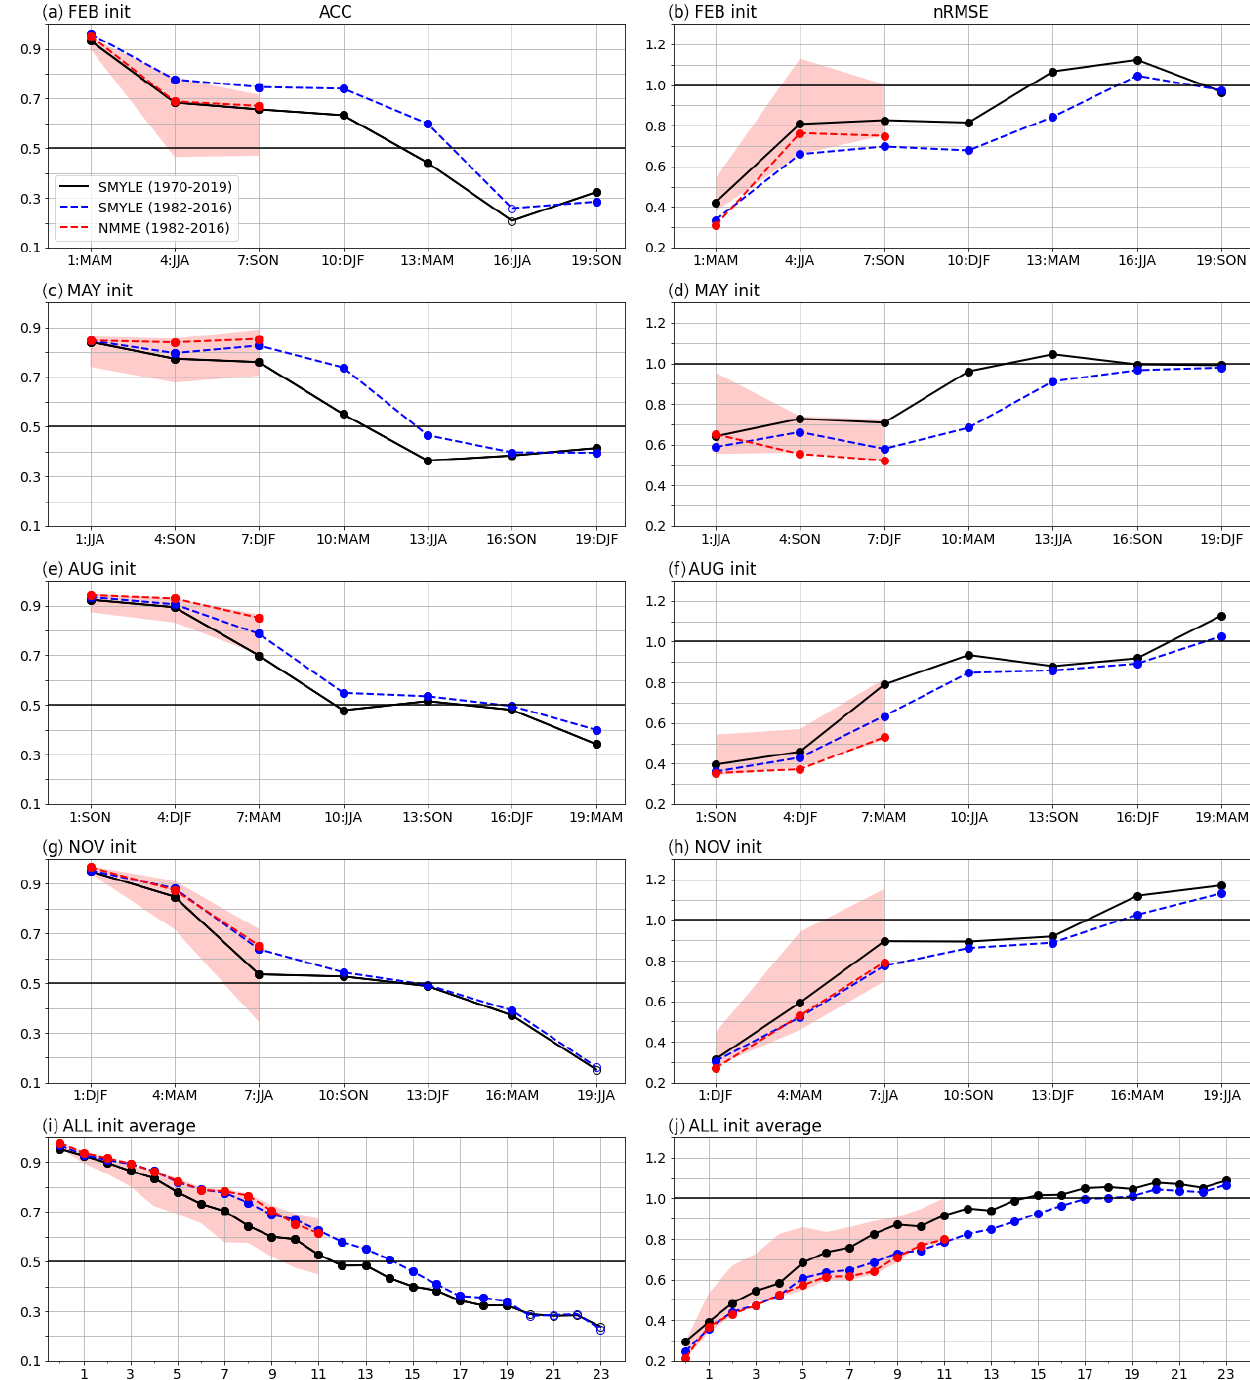
Figure 3. Anomaly correlation coefficient (ACC) on the left and normalized RMSE skill scores on the right for Niño-3.4 SST (regional average over 5 ◦ S–5 ◦ N, 170–120 ◦ W). Panels (a) – (h) show skill for seasonal mean Niño 3.4 for 4 different start months (FEB, MAY, AUG, NOV), with the x axis showing lead time in months and target season. Panels (i) and (j) show skill for monthly mean Niño 3.4 averaged across all 4 start months as a function of lead time in months. Filled symbols for ACC (left panels) indicate significant correlation scores ( p < 0.1). SMYLE skill is shown for two different forecast sets: the full set initialized 1970–2019 (solid black curve) and a subset initialized 1982–2016 (dashed blue curve). The latter can be directly compared to NMME results, which are shown as scores for the full multi-model ensemble mean (dashed red curve) as well as the range of scores from eight individual NMME models (red shading). The verification dataset is